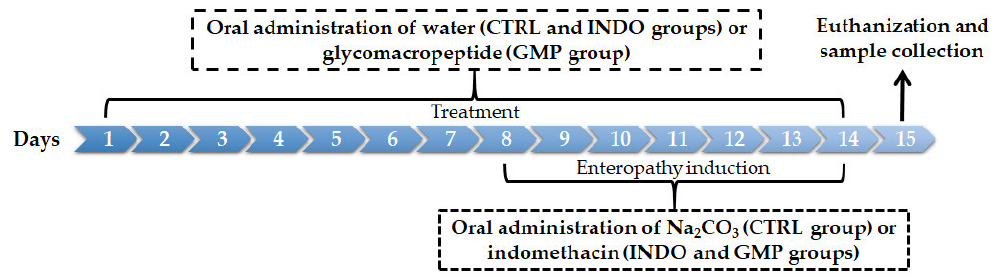
Figure 8. Schematic diagram of experimental protocol for indomethacin-induced enteropathy and glycomacropeptide (GMP) administration.